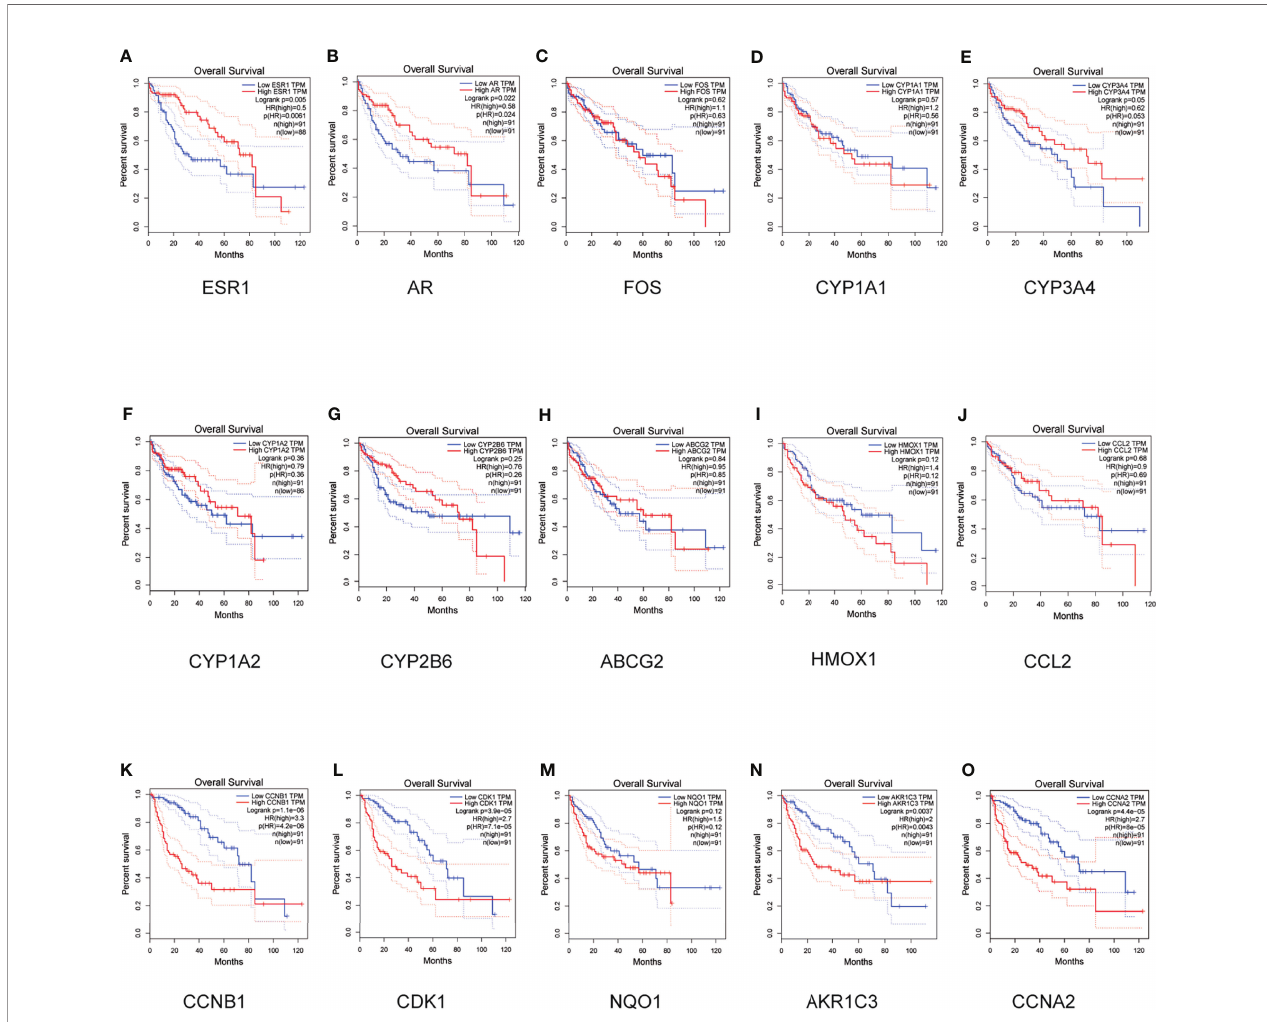
FIGURE 4 | Survival analyses for hub genes. OS of the 10 down-regulated and 5 up-regulated hub genes was analyzed by Kaplan-Meier plotter. Data are presented as the hazard ratio with a 95% con fi dence interval. The log-rank P of the down-regulated hub genes ESR1 (A) , AR (B) , FOS (C) , CYP1A1 (D) , CYP3A4 (E) , CYP1A2 (F) , CYP2B6 (G) , ABCG2 (H) , HMDX1 (I) and CCL2 (J) were 0.005, 0.022, 0.62, 0.57, 0.05, 0.36, 0.25, 0.84, 0.12 and 0.68. The log-rank P of the up-regulated hub genes CCNB1 (K) , CDK1 (L) , NQO1 (M) , AKR1C3 (N) and CCNA2 (O) were 1.1e-06, 3.9e-05, 0.12, 0.0037 and 4.4e-05. Log-rank P < 0.05 was regarded as statistically signi fi